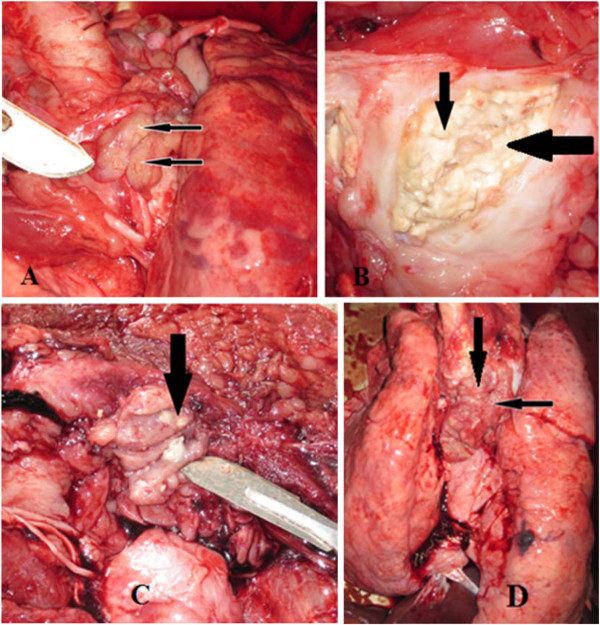
Tuberculous lesions in various tissues of pigs at slaughter. Tuberculous lesions indicated by solid arrows in various lymph nodes of pigs at slaughter. Bronchial lymph node (A), submandibular lymph nodes (B, C) and enlarged mediastinal lymph node (D).